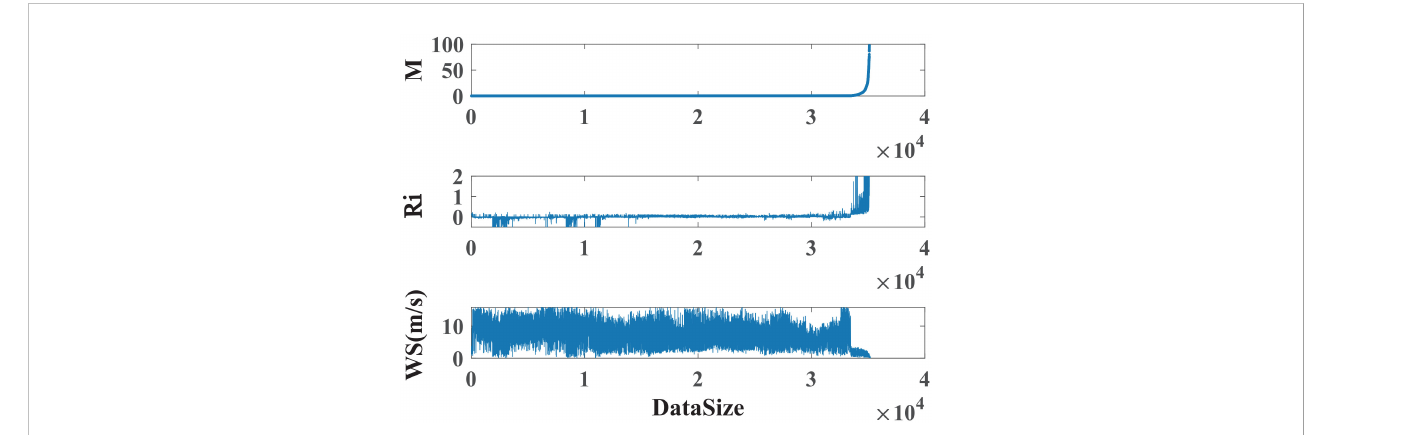
FIGURE 8 Relationship between the M deviation and Ri , as well as that between the M deviation and WS.